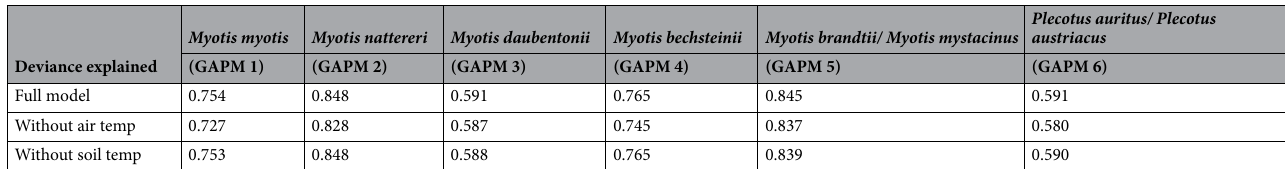
Table 4. Deviance explained depending on variable